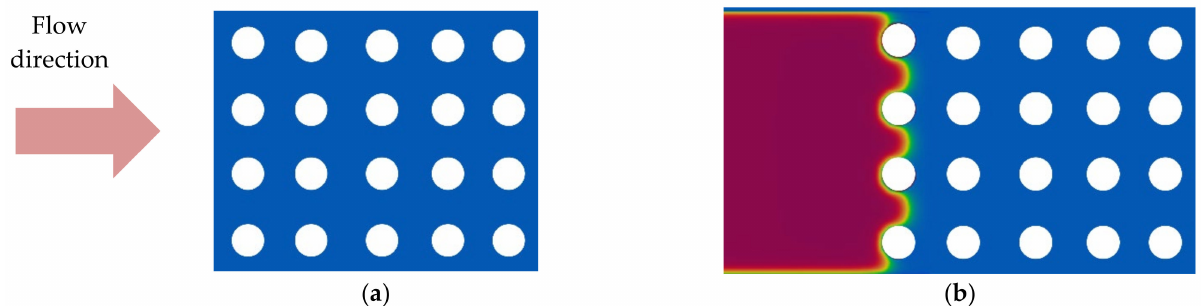
Figure 7. CO 2 displacement process with insufficient body force of 2.5 × 10 − 5 . The same color scheme is used, as in Figure 6. ( a ) Geometry of the porous media with porosity 0.78. ( b ) CO 2 penetration at 113,400